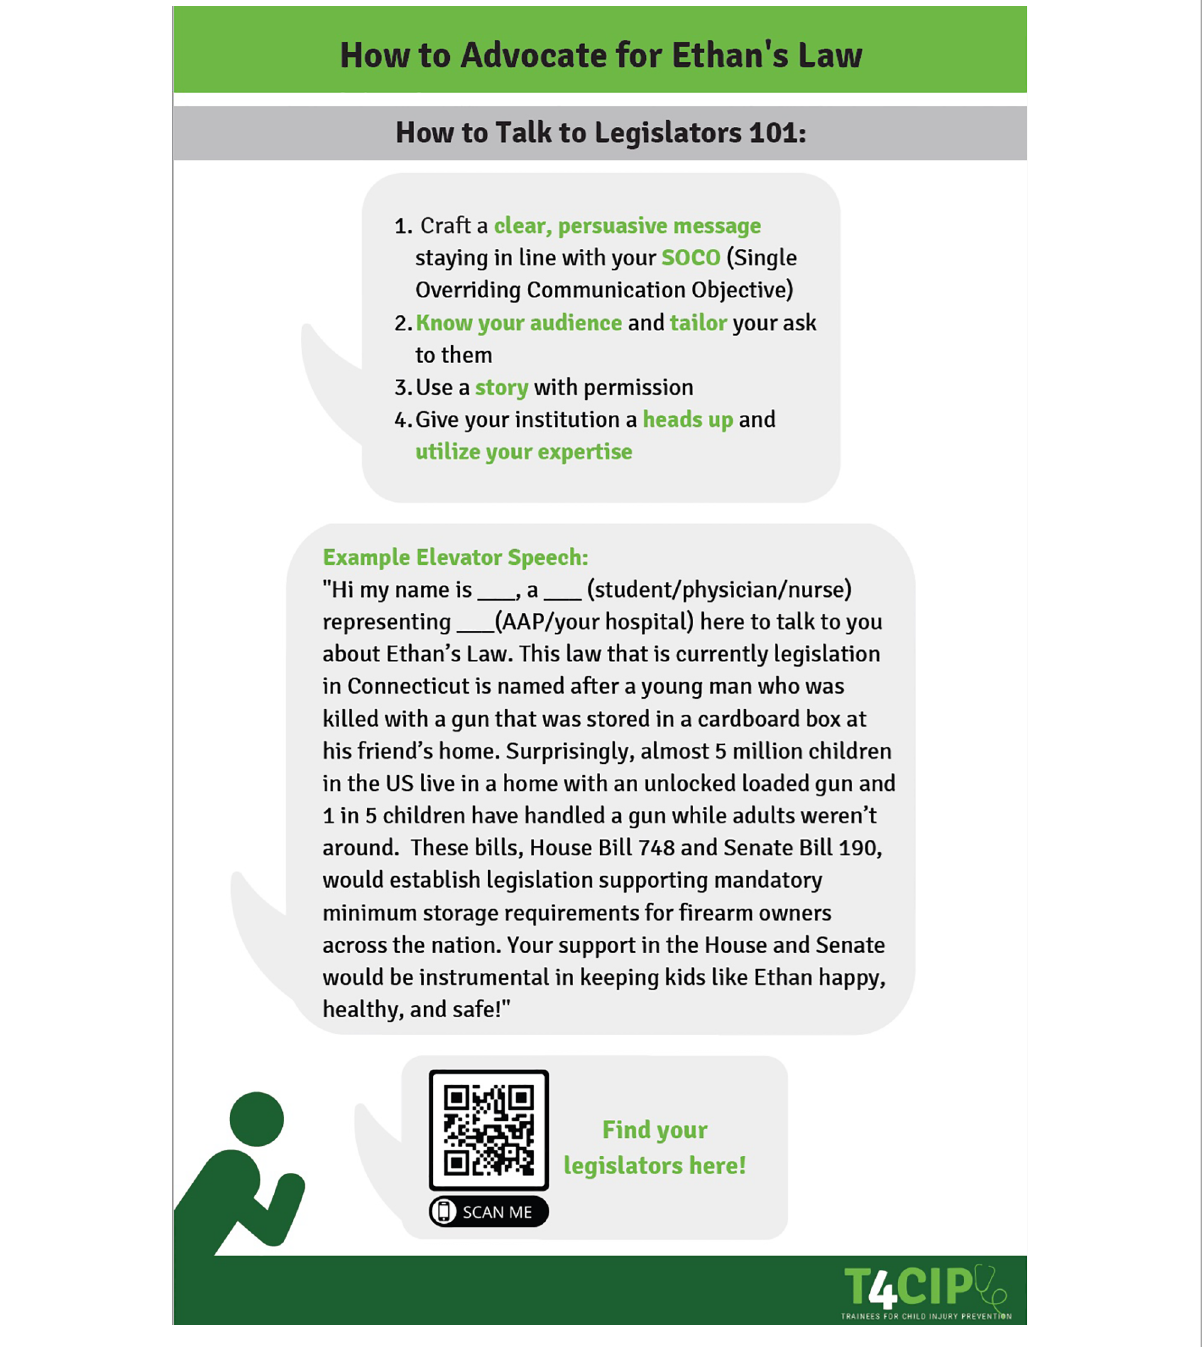
FIGURE 4 Second Policy “ Guide ” : Child access prevention laws part